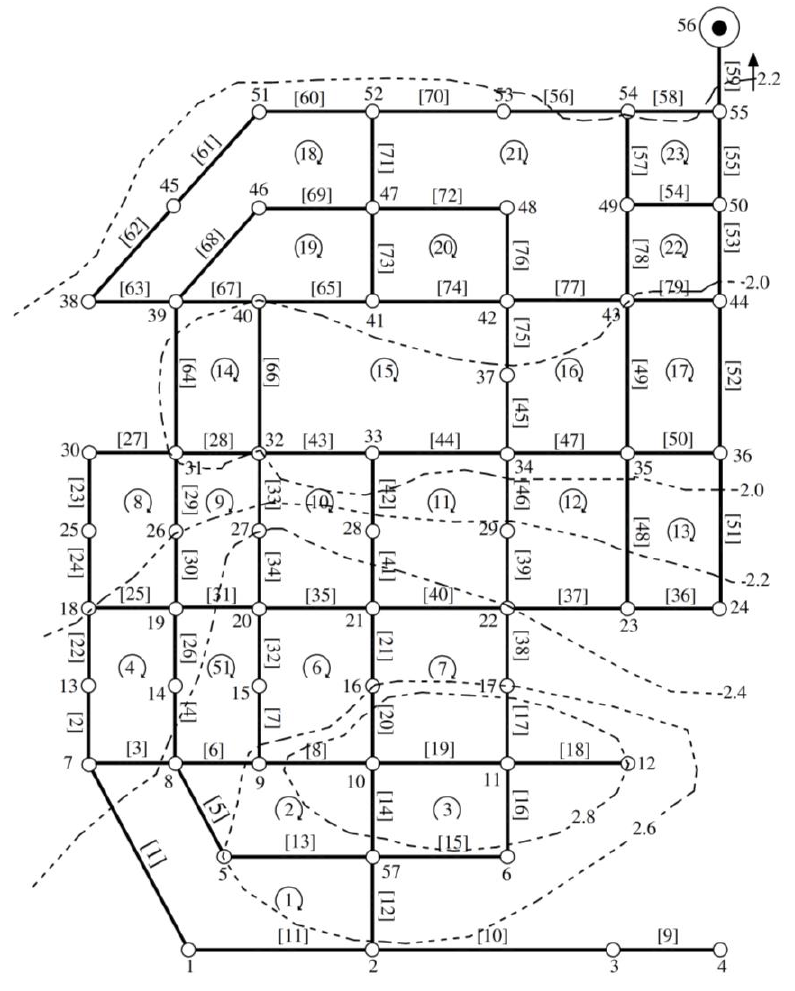
Figure 2. Base graph of the case study (data from Li and Matthew